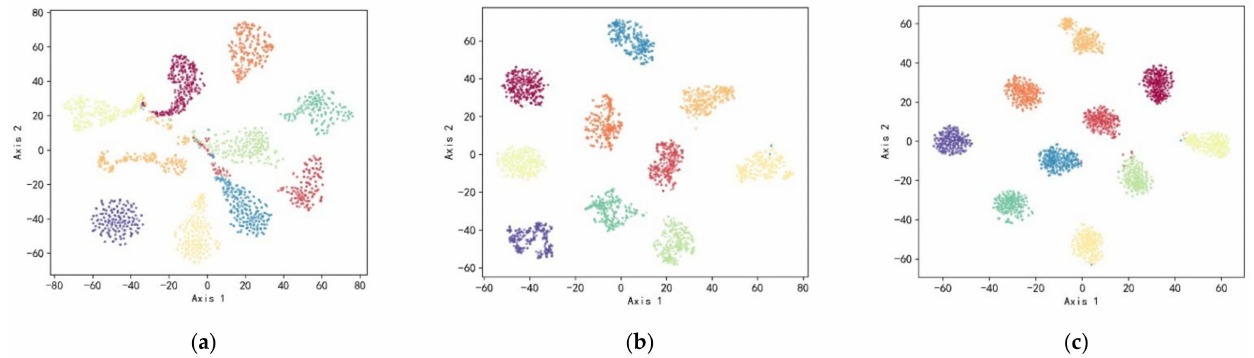
Figure 9. Comparison of t-SNE diagrams of experimental results on data set C. ( a ) The t-SNE graph of data set C; ( b ) the t-SNE diagram of HSDAE features without discriminant distance; ( c ) the t-SNE diagram of HSDAE